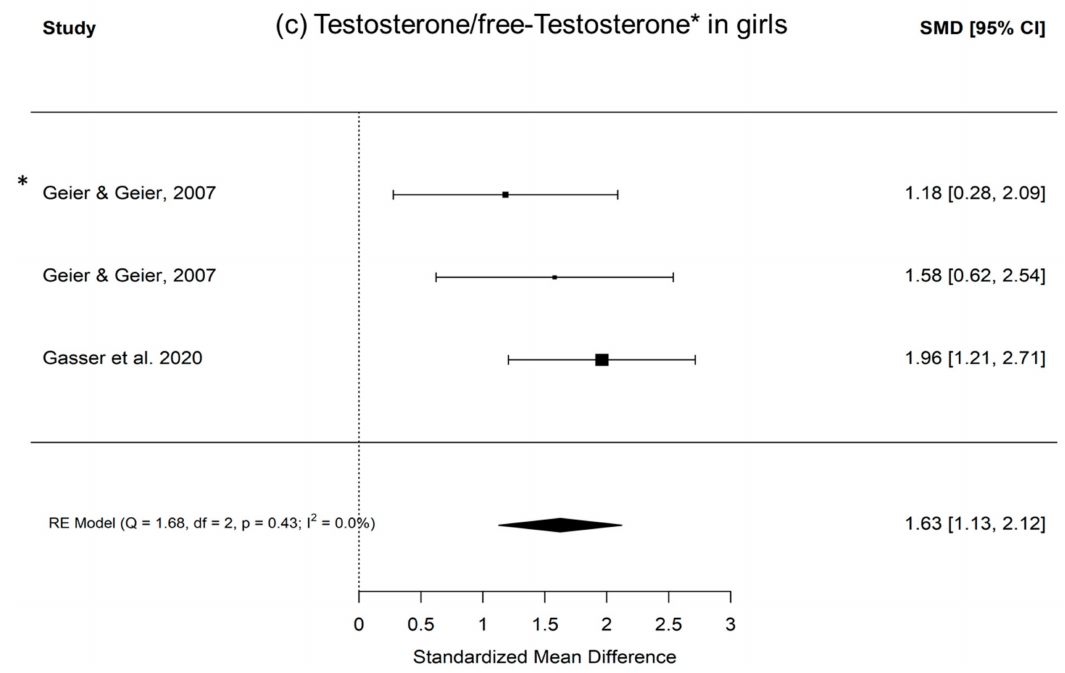
Figure 4. ( a – c ) Random effects models with significance level, Cochrane Q, I 2 , and effect sizes of analyzed metabolites in girls with autism versus healthy controls. ( a ) Androstenedione/androstenediol indicated with *; ( b ) DHEA; ( c ) testosterone/free testosterone indicated with *.